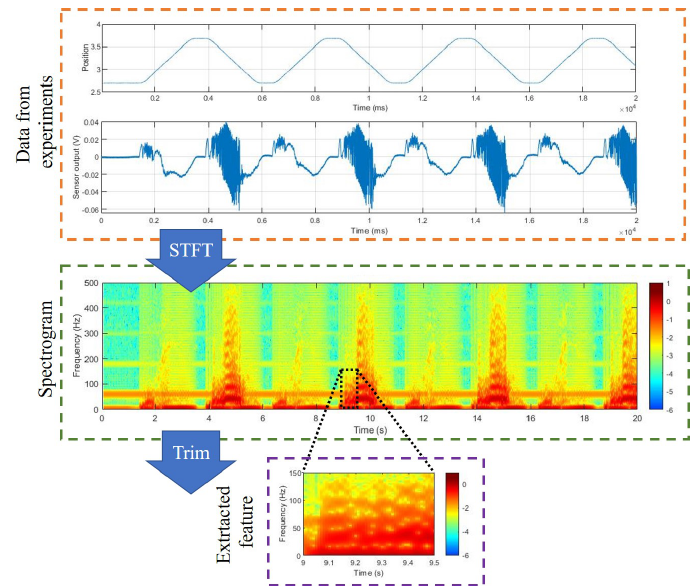
Figure 3. Extracted